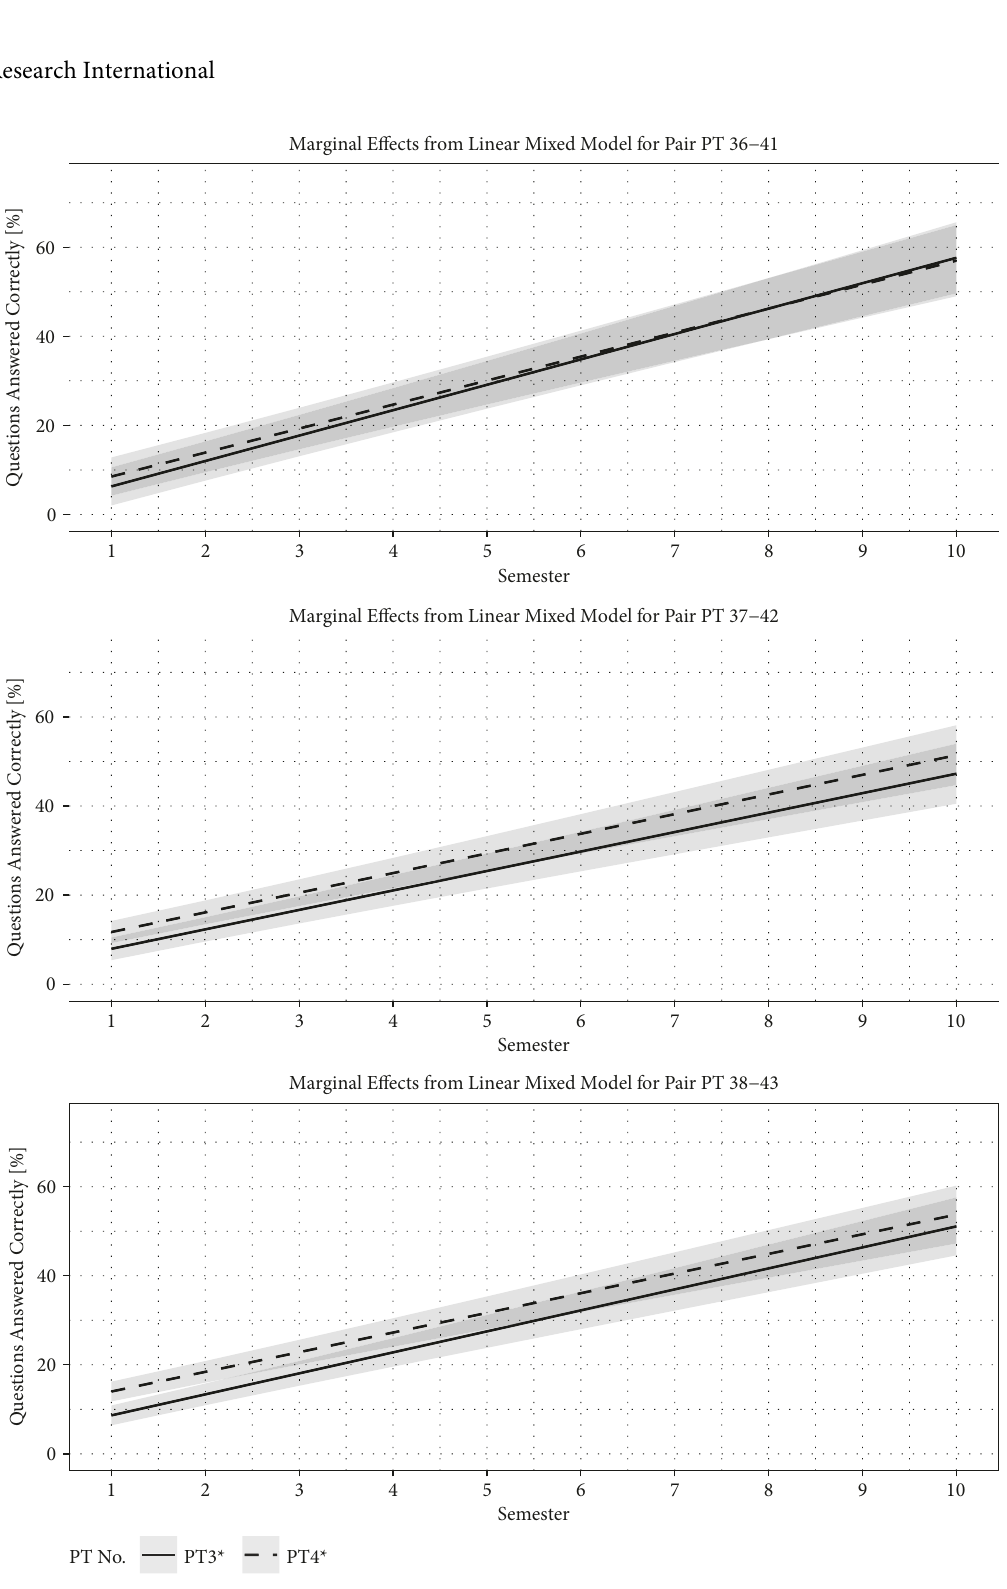
Figure 2: Results of the linear mixed model described in the article for each of the three PTpairs considered. Every PTshares a considerable number of questions with the PTthat took place five semesters before; tests were conducted at nine different German and Austrian faculties. In these graphics, test modalities are fixed by their weighted estimates. The x -axis represents the semesters, while the achieved relative scores are shown on the y -axis. The dashed line represents the most recent test in each pair (41 � winter semester 2019/20, 42 � summer semester 2020, and 43 � winter semester 2020/21); the gray areas are the respective 95% confidence intervals. The difference in mean scores for students in earlier semesters (36 � summer semester 2017; 37 � winter semester 2017/18; 38 � summer semester 2018) increases with every successive pair, while the results of the pair PT37-PT42 seem to equally improve throughout all semesters; the scores of the other two pairs converge with increasing semesters. PT, Progress Test; ePT, electronic Progress